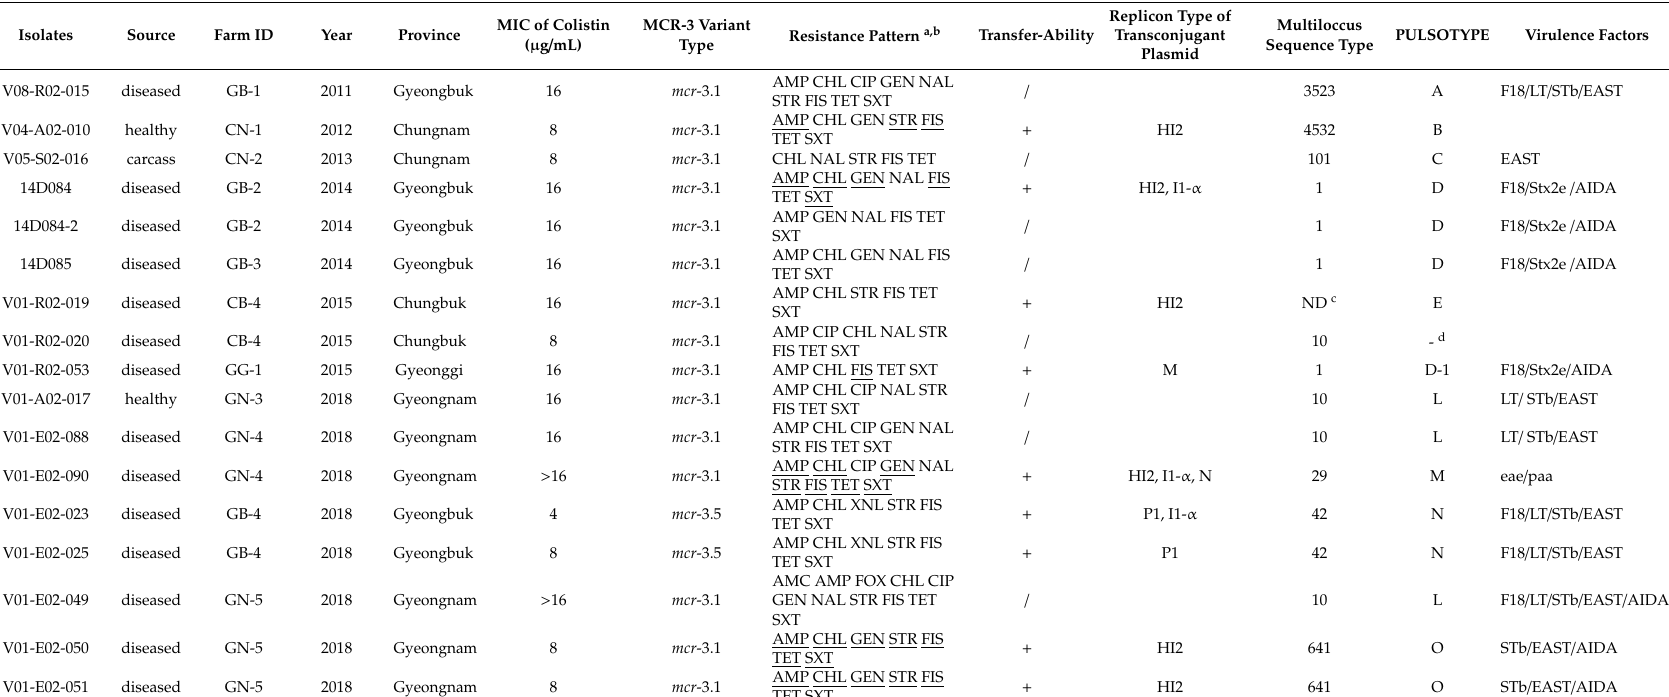
Table 2. Characteristic of the mcr-3 positive Escherichia coli from healthy and diseased pigs, and pig carcasses in